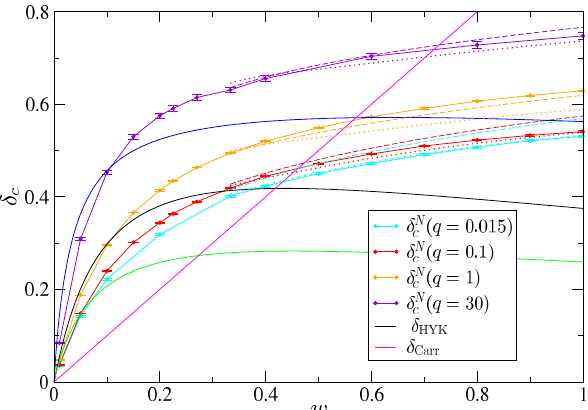
Figure 24. Dependence of threshold δ c on w when the initial profile is given by Equation (83) with q = 30, q = 1, q = 0.1, q = 0.015, and λ = 0 in all the cases ( q = 0 would be a homogeneous sphere in the compaction function). The solid lines with dots and error bars show the results of the numerical simulations. The green and blue curves show the minimal and maximal bounds of δ c from [75], in particular Equations (95) and (96), respectively. The magenta line shows the approximation for δ Carr of Equation (92). The black curve shows δ HYK from Equation (94). The other curves show the approximation (Equation (108)) in which δ c depends both on w and q . Finally, the dotted curves use Equations (111) and (112) in Equation (108), whereas the dashed curves use Equations (109) and (110) in Equation